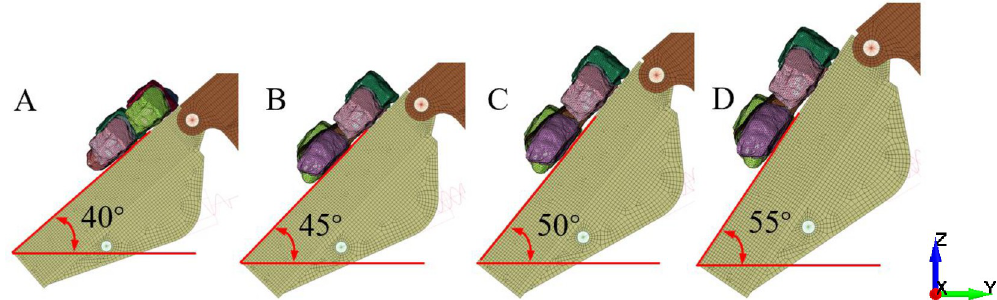
Fig 24. Different tail beam angle. (A) Tail beam angle is 40˚. (B) Tail beam angle is 45˚. (C) Tail beam angle is 50˚. (D) Tail beam angle is